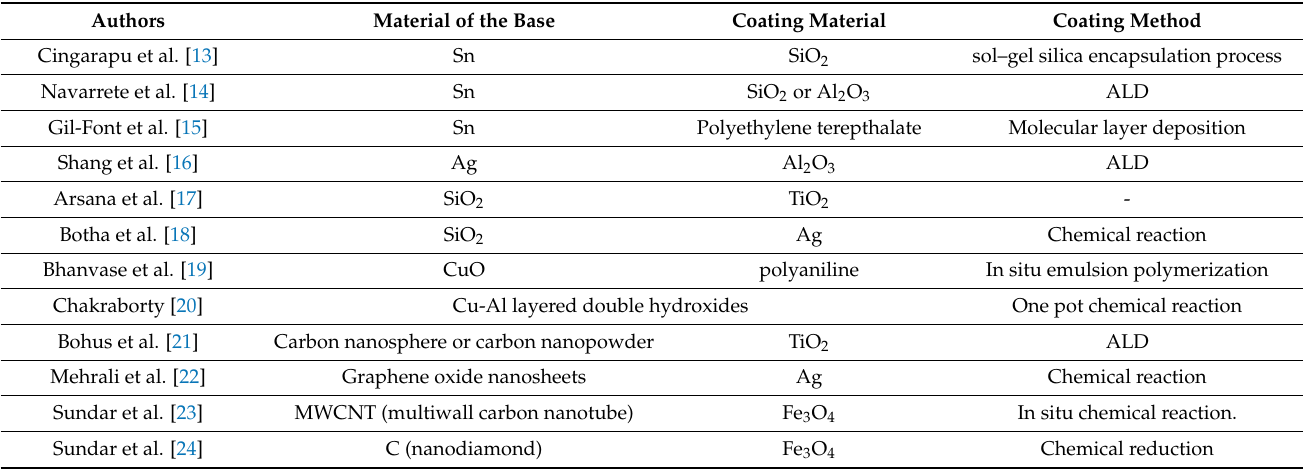
Table 1. Examples of composite particles used in